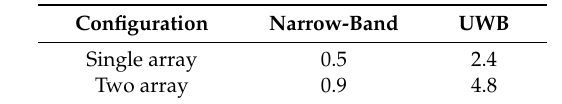
Table 3. Computation times of the operator matrix in